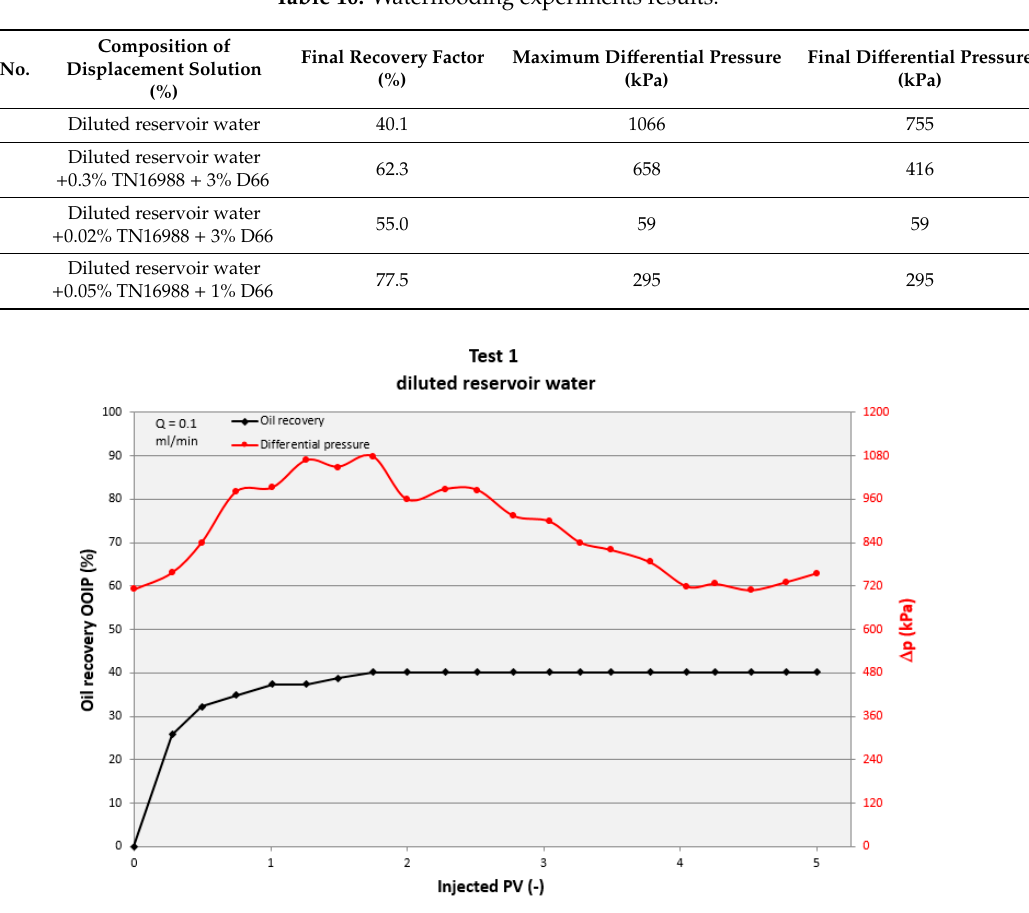
Table 10. Waterflooding experiments results.